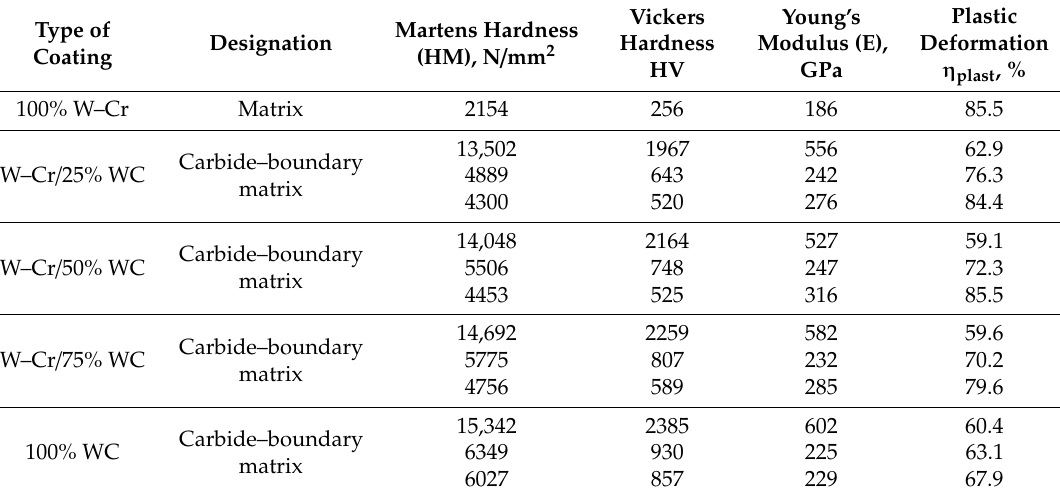
Figure 18. Example of the instrumented indentation test for W–Cr / 50% WC coating; ( a ) in carbide; ( b ) boundary between carbide and matrix; ( c ) matrix. Table 4. Average results of the instrumented indentation test for produced coatings for the following areas: carbide, boundary between carbide and matrix, and matrix.